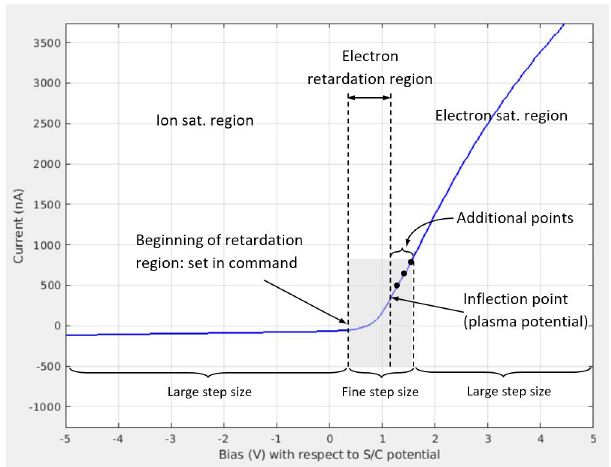
Figure 2. Example of sweep using the adaptive algorithm.